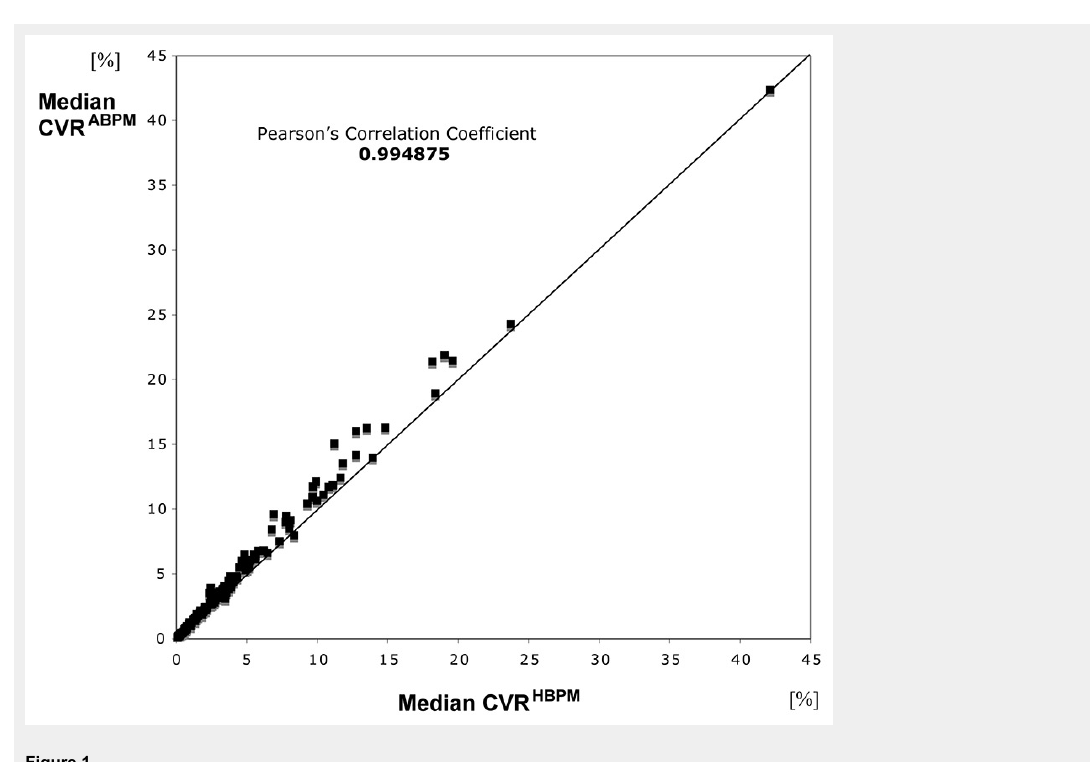
Figure 1 Correlation between CVR ABPM and CVR HBPM , calculated by use of median blood pressure levels.